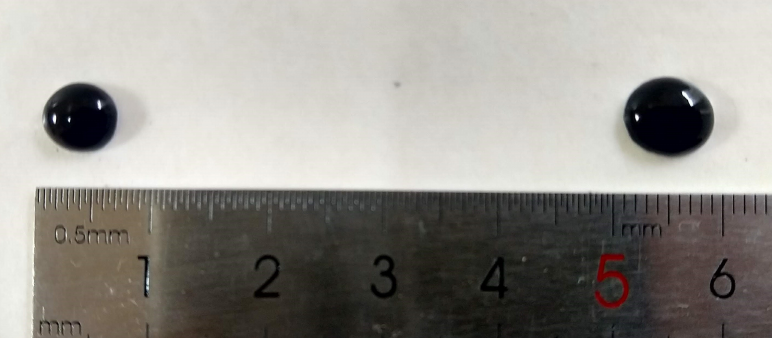
Figure 1. Example of two drops of the proposed ferrofluid pheromone substance after deposition.